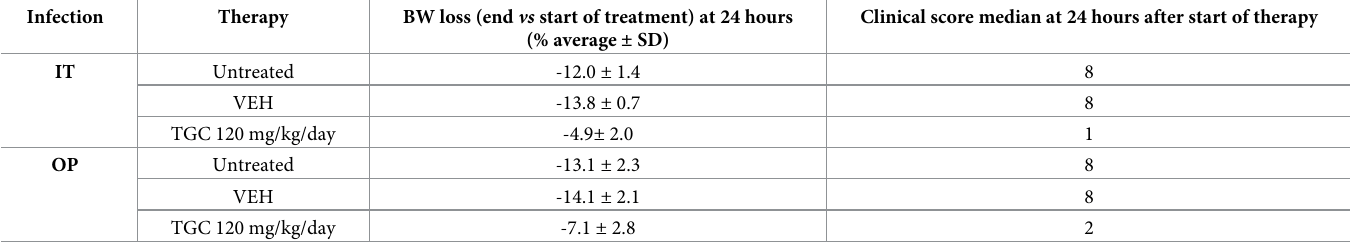
Table 6. Body weight and clinical score.